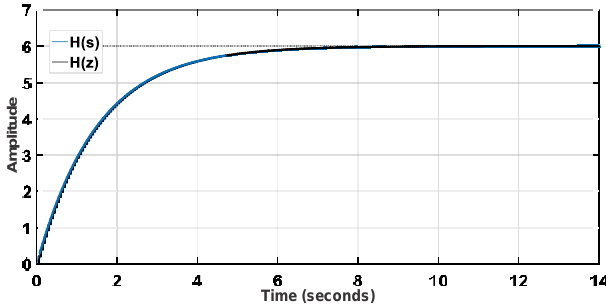
Figure 7. Step response of the plant models.